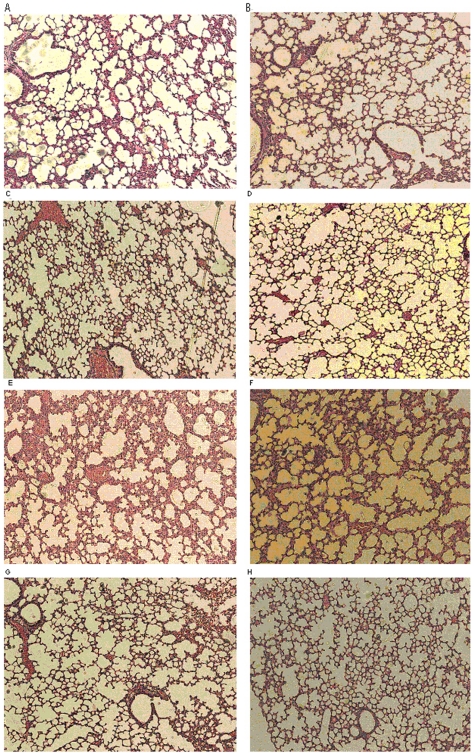
Histological lesions of lung tissue detected by hematoxylin and eosin (HE) staining in mice 4 days post-challenge with 10 MLD50 (A to D) or 1,000 MLD50 (E to H) of homologous (A/Shenzhen/406H/06, clade 2.3.4) H5N1 virus.A and E) PBS control group; B and F) homologous VLP-VLP prime-boost group; C and G) homologous DNA-DNA prime-boost group; D and H) heterologous DNA-VLP prime-boost group.